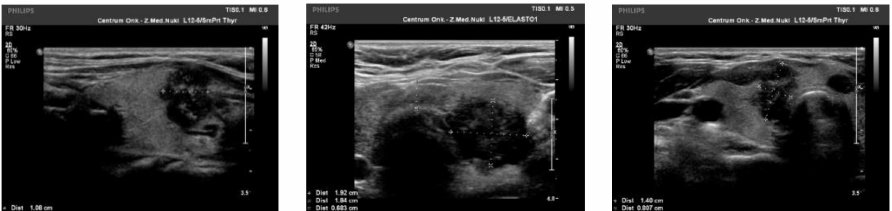
Figure 2. US image of BRAF V600E positive PTCs: solid structure (2 points), deeply hypoechogenic, (3 points), taller-than-wide orientation (3 points), blurred margins (2 points), microcalcifications (3 points)—13 points = TIRADS